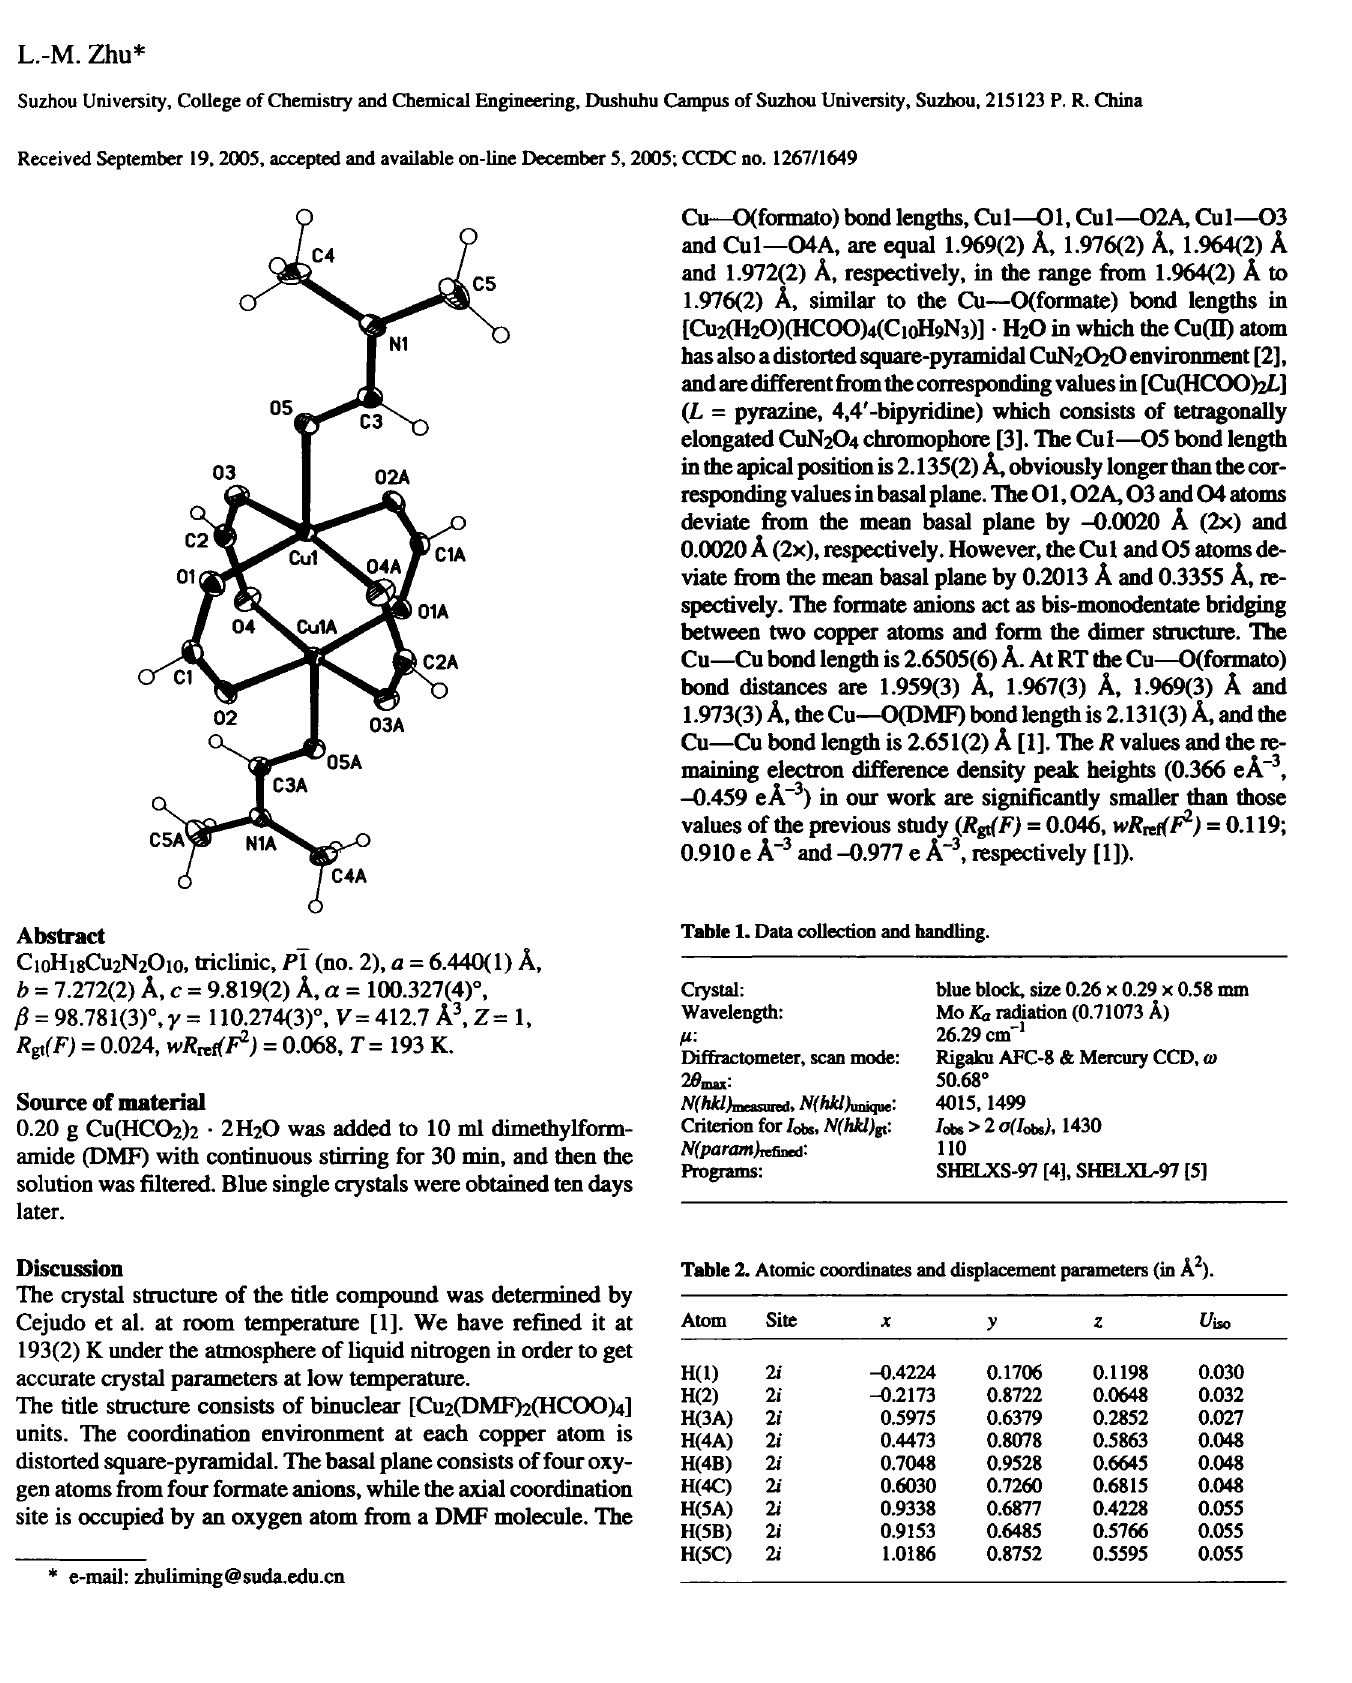
Table 2. Atomic coordinates and displacement parameters (in Ä 2